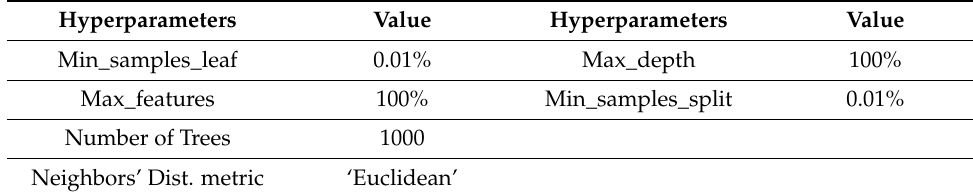
Table 4. Optimum Hyper-Parameters